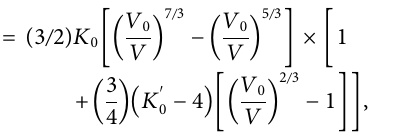
Frontiers in Earth Science |